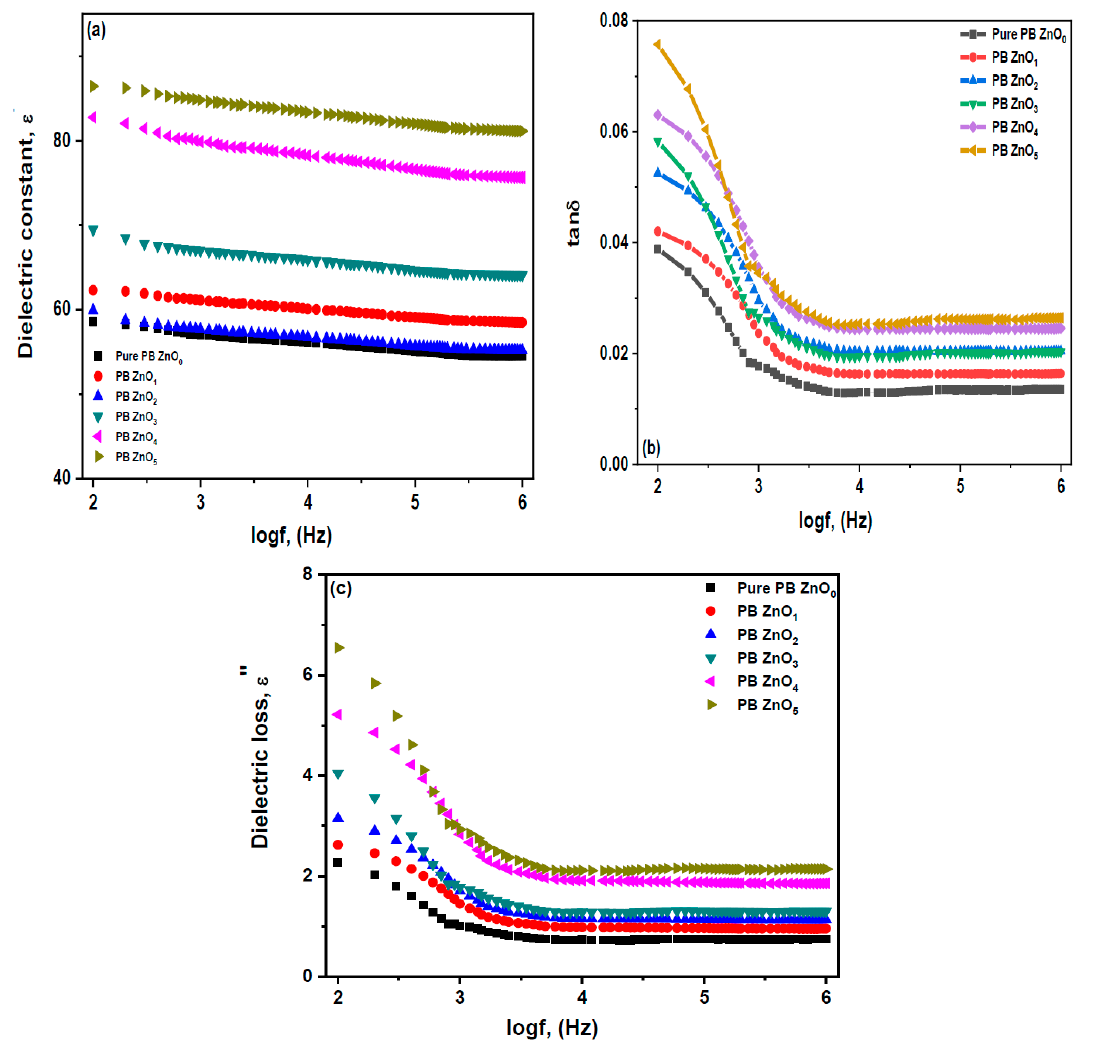
Figure 9. ( a – c ): ( a ) Real part of dielectric permittivity, ( b ) tan δ , and ( c ) imaginary part of dielectric permittivity against angular frequency for PB ZnO nanocomposite films . permittivity against angular frequency for PB ZnO nanocomposite